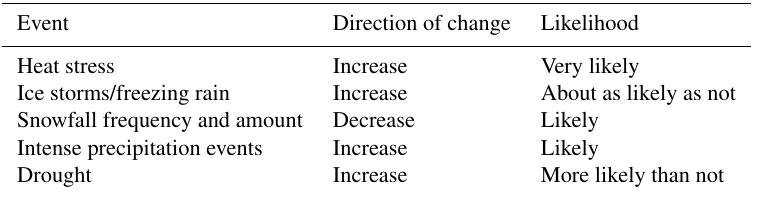
Figure 1. Map of Goddard Space Flight Center. Flags indicate locations of loggers at the center. Loggers were strategically placed in low-traffic areas of the center to minimize the potential for disturbance. Table 1. Qualitative changes in extreme events for GSFC based on global climate model simulations, published literature, and expert 66% about as likely as not (Rosenzweig et al.,